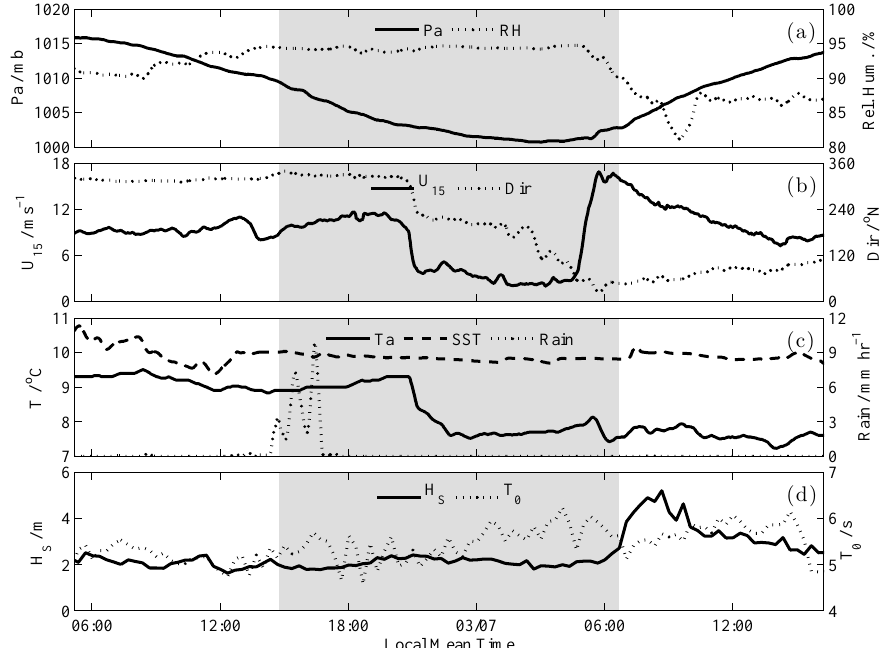
Fig. 6. (a) Pressure (Pa), relative humidity (RH), (b) wind speed at 15.5m ( U 15 ), wind direction (Dir, clockwise from north), (c) air temper- ature (Ta), sea surface temperature (SST), rainfall rate (Rain), (d) significant wave height and mean crossing period are shipboard measure- ments from the R/V Knorr for the deployment location in Fig. 1. The shaded region corresponds to the time when ASIP was profiling.